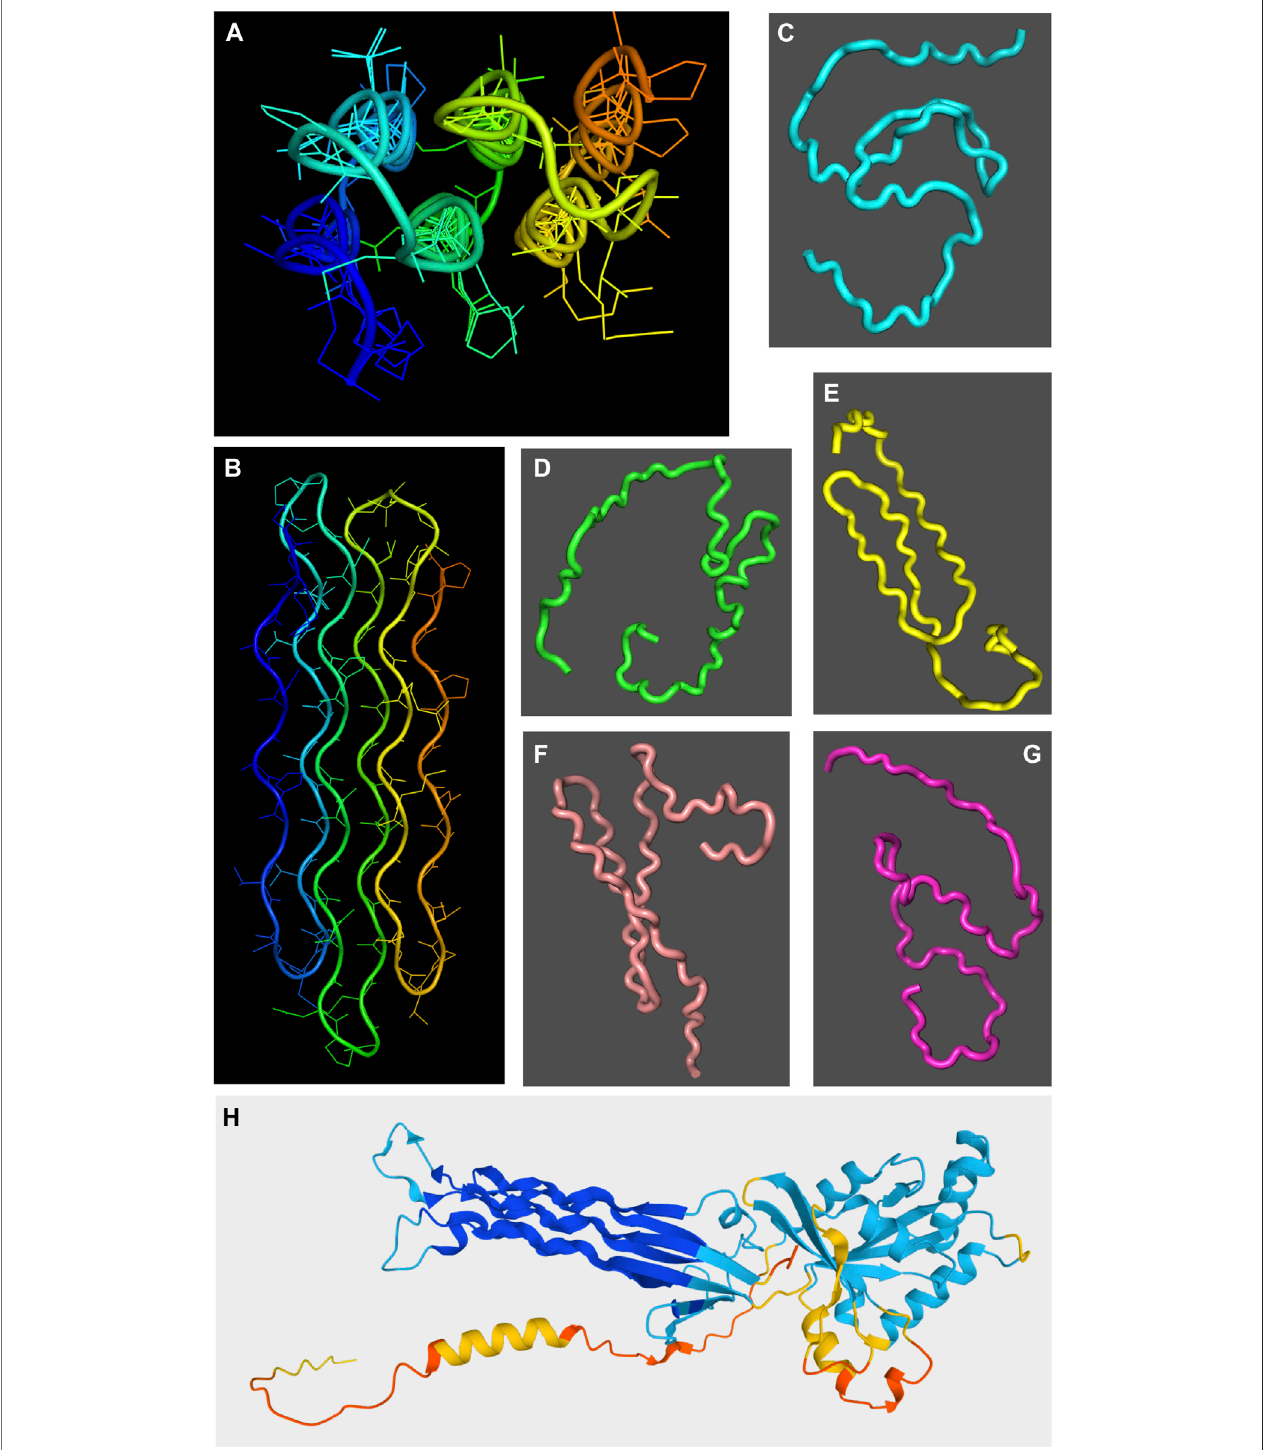
FIGURE3 | Chiaroscuro in AlphaFold 2prediction ofpolyproline IIhelical bundle proteins. The snow fl ea antifreezeprotein (sfAFP; PDB 3BOG) structure assolved byX-raycrystallography(Penteluteetal.,2008)isshownintwoorientationsinpanels (A,B) withthechaincoloredinarainbow bluetoredspectrum fromtheN-terminus to the C-terminus. In panels (C – G) , fi ve AlphaFold 2 structural models are shown for the sfAFP protein over a dark gray background. Whereas some polyproline II-like extended conformations are seen in structures shown in panels (E,F) , overall the method does not succeed in predicting sfAFP ’ s structure. By contrast, the essentiallycorrectAlphaFold2structuralmodelofthe E.coli ObgGTPaseisshowninpanel (H) .Theribbonmodeliscoloredfromblue(veryhighcon fi dence)tored(very low con fi dence). The polyproline II helical domain, colored blue, is the region predicted with the highest con fi dence throughout the entire structure.